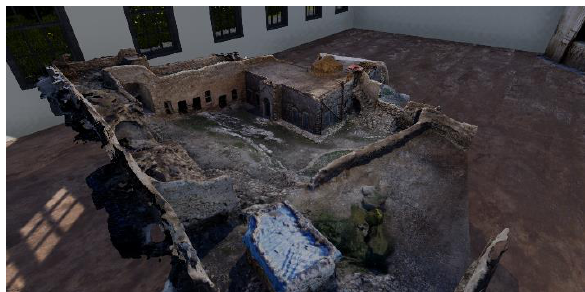
Figure 14. Texture detail – inside